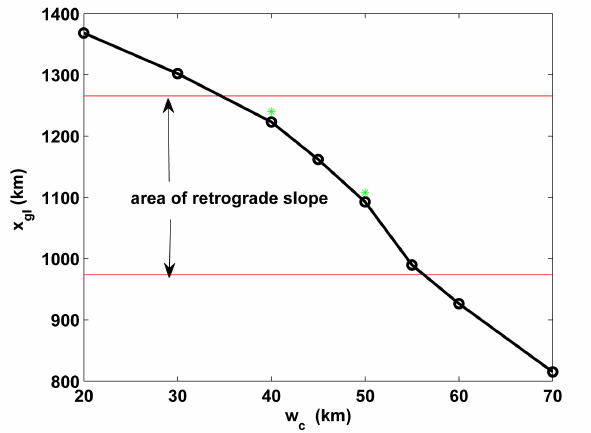
Fig. 6. Stable grounding-line positions along the medial line as a function of channel half-width. The data points shown as black cir- cles are based on results obtained using ´Ua. The data points shown as green stars were obtained with